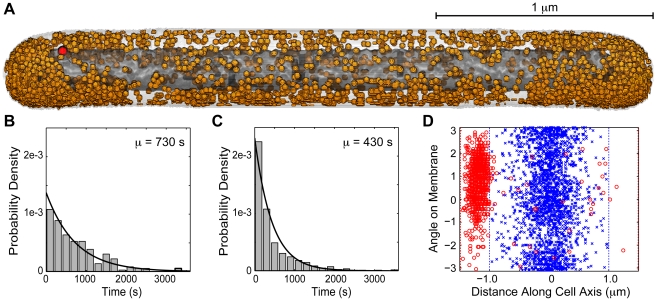
Analysis of cryoelectron tomography based cell model.(A) Slow growth E. coli cell model based in part on data from a tomographic reconstruction. Shown are (orange) ribosomes, (light gray) membrane, (dark grey) condensed nucleoid, and (red) lac operator. (B+C) Distribution of repressor–operator complex lifetimes for the fast and slow growth models, respectively. Curves show fits to an exponential distribution with the given mean. (D) Position of mRNA–membrane contact after diffusion of mRNA produced at the lac operon in (blue x) fast growth and (red o) slow growth models. Dotted lines show the length of the respective cells.